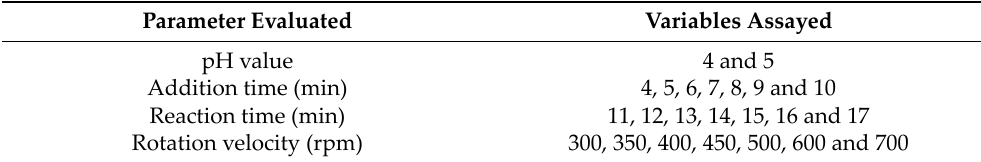
Table 1. Assayed production